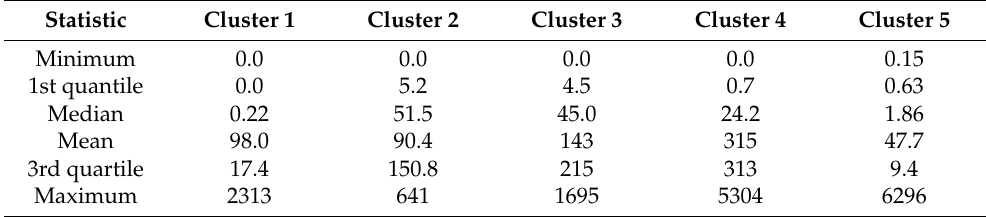
Table 4. Statistical summary of hourly BC ff source contributions (ng/m 3 ) for a 5-cluster